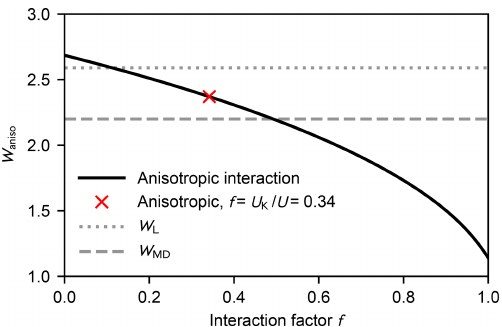
Figure A1. Enhancement factor W aniso over the kinetic gas the- ory calculated from the anisotropic dipole–dipole collision cross section as a function of the interaction factor f at 300K (black solid line). The red cross denotes the case where the dipole–dipole contribution of the total interaction equals the Keesom equation Eq. (A11) ( W aniso = 2 . 41). The enhancement factors obtained from the Langevin model and the MD simulations are shown as the dotted and dashed grey lines,